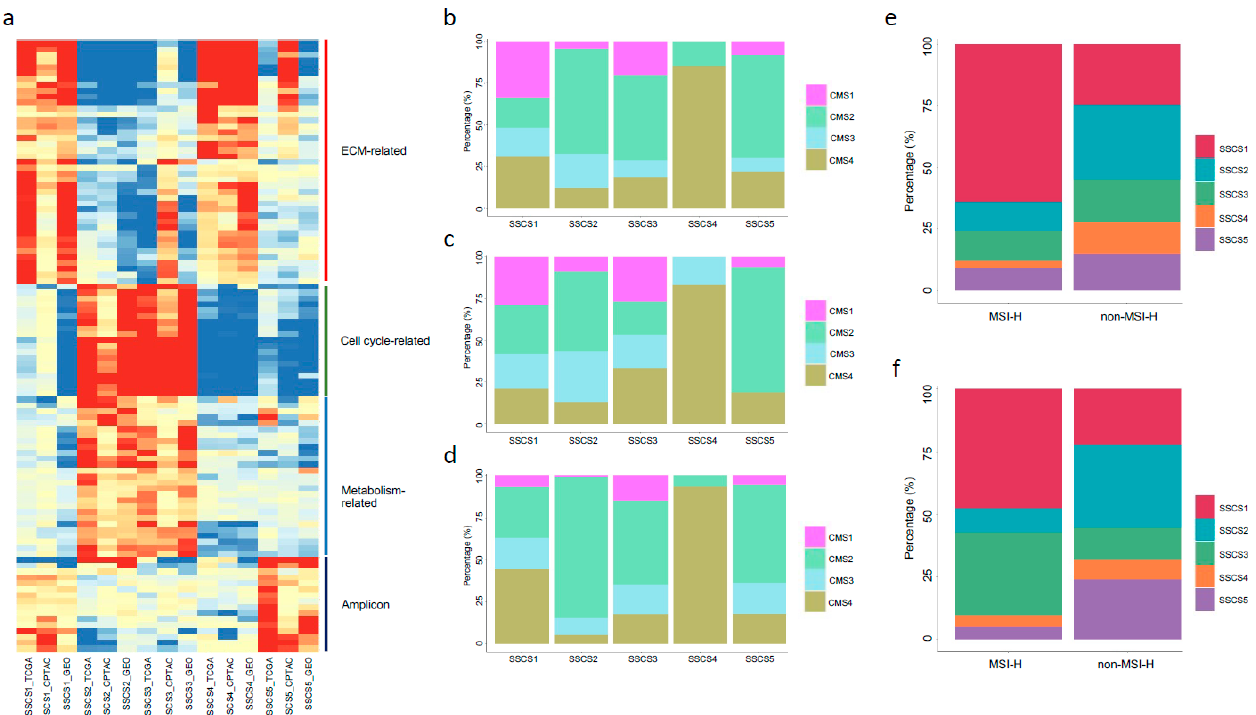
Figure 4. SSCS subtypes molecular features and comparisons with other subtypes. ( a ). A p -value heatmap representing dysregulated gene sets between the five SSCS subtypes. In the heatmap, columns correspond to different subtypes in the three cohorts, and rows to gene sets. Values in the heatmap were − log10 (FDR adjusted p -value) transformed. Red color indicates up-regulated gene sets, and green means down-regulated gene sets in the corresponding groups. Gene sets were grouped into different functional categories, with representative functional names shown on the right hand of the heatmap accompanied by a colored line, respectively (such as light red for EMT-related, light green for cell cycle-related, and blue for metabolism-related gene sets). The patient’s proportion bar plots illustrate the percentage intersections between the SSCS and CMS labels in the TCGA ( b ), CPTAC ( c ), and GEO ( d ) cohorts. The patient’s proportion bar plots illustrate the percentage intersections between the SSCS and MSI labels in the TCGA ( e ) and CPTAC ( f ) cohorts.